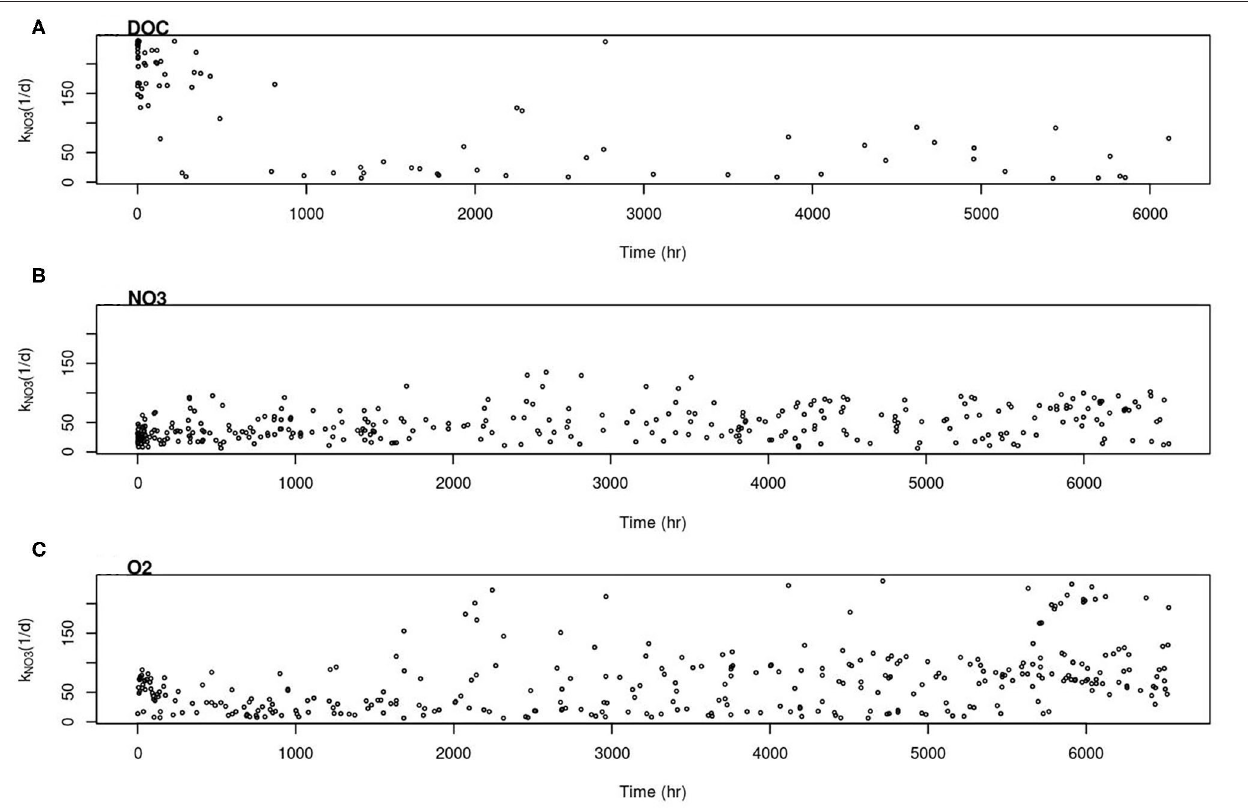
FIGURE 10 | Parameter range of rate constant for nitrate reduction reaction in TSM that can best fit (A) CH 2 O, (B) NO 3 − 1 , and (C) O 2 .